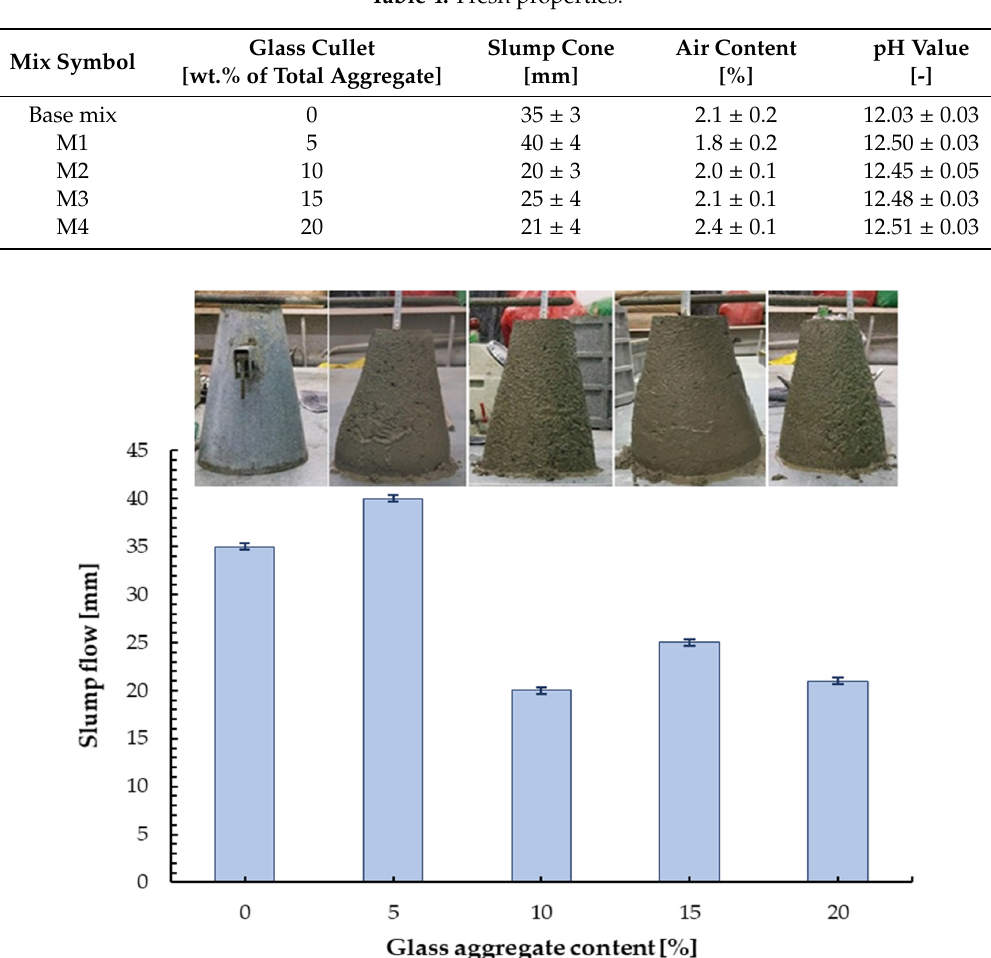
Figure 6. Slump cone test results after 150 s.